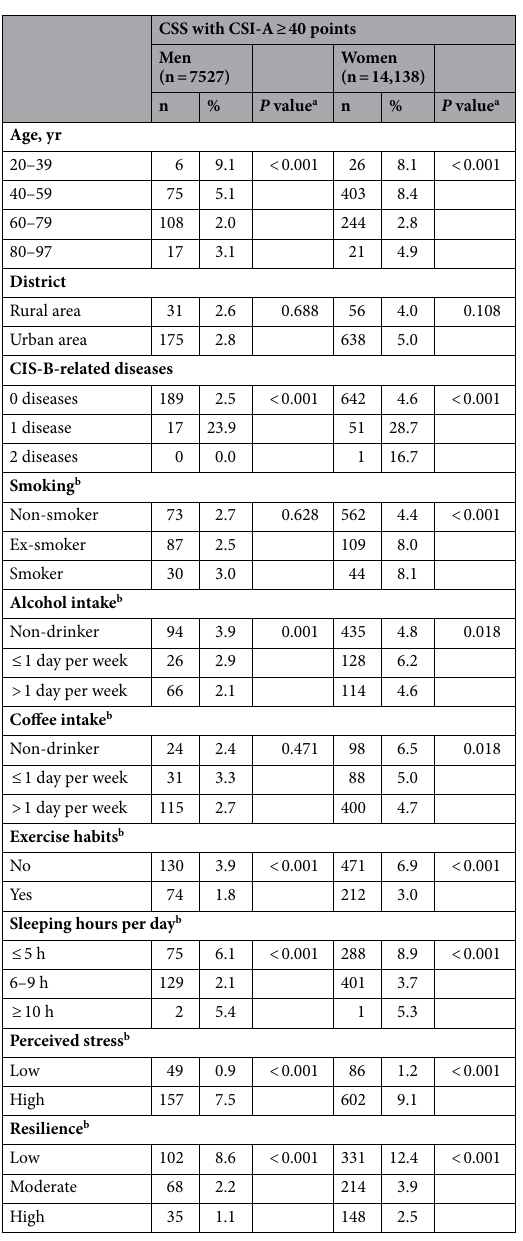
Table 2. Prevalence of CSS with CSI-A ≥ 40 points in each variable by sex. CSS Central sensitization syndrome, CSI Central sensitization inventory. a Using the chi-squared test or Fisher’s exact test. b Participants with missing values for smoking (n = 494), alcohol intake (n = 1522), coffee intake (n = 3761), exercise habits (n = 458), sleeping hours per day (n = 69), perceived stress (n = 198), and resilience (n = 120) were